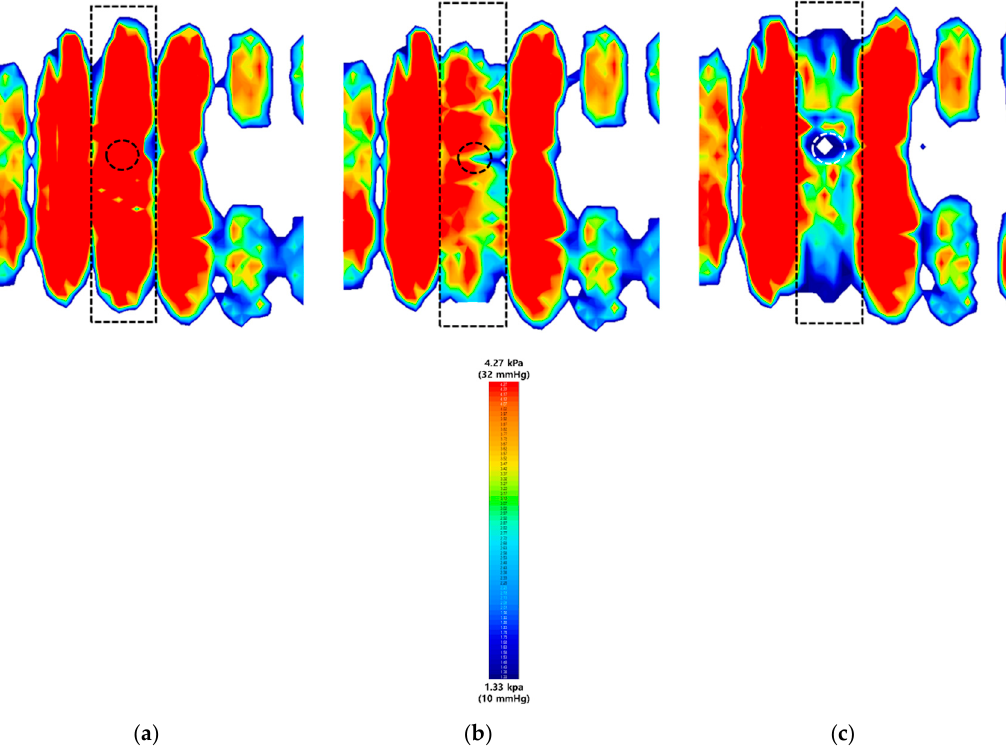
Figure 10. Description of changes in interface pressure, ( a ) without any air-flow control, ( b ) with a passive air-flow control, and ( c ) with an active air-flow control. These colors were visualized by commercial equipment of X3Pro.